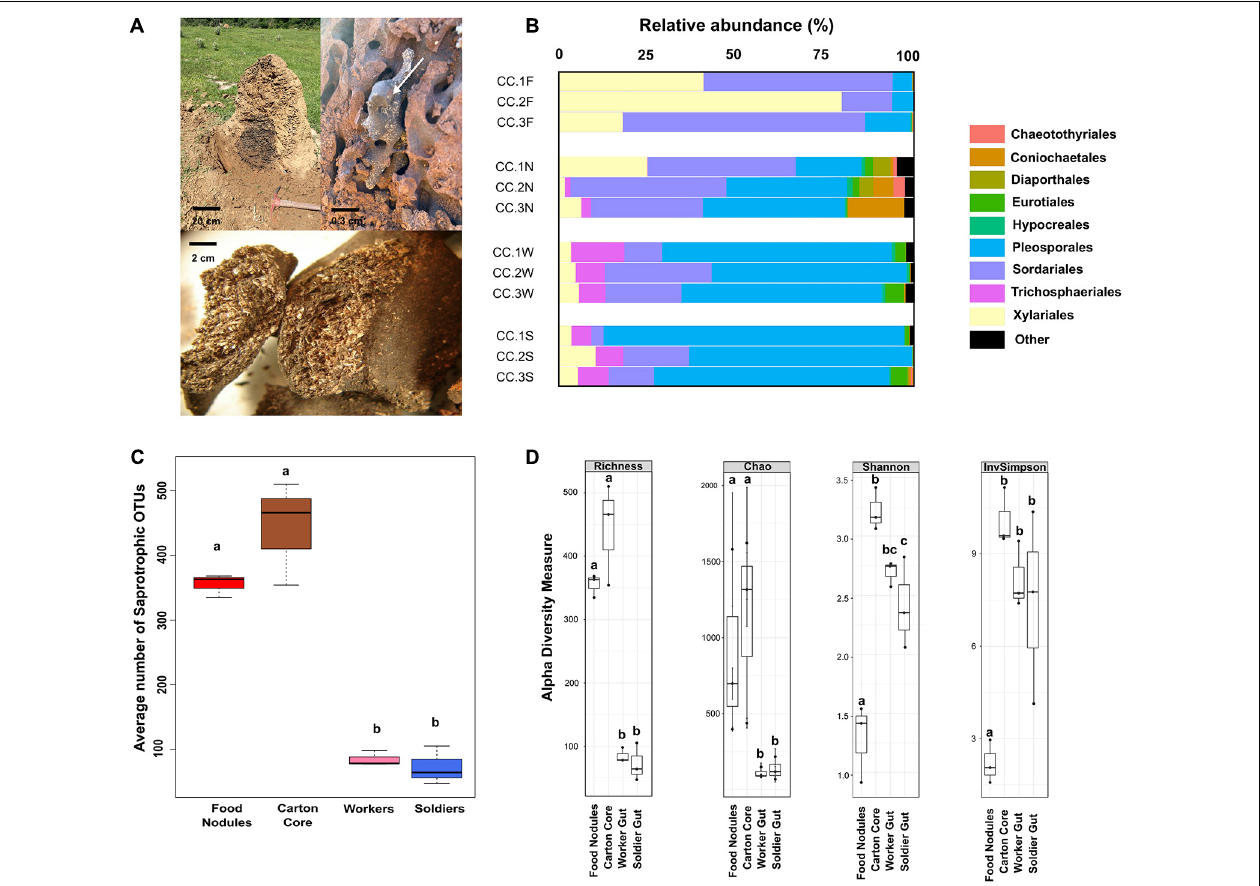
FIGURE 1 | (A) Nest of Cornitermes cumulans showing the central carton core with a food nodule (arrow) and a zoomed picture of the plant material inside a food nodule. (B) Proportion of reads assigned to different fungal orders in gut and nest substrates for each sampled colony. (C) Average number of saprotrophic fungal OTUs associated to each one of the samples. (D) Alpha-diversity indices estimated for fungal ITS amplicons. Graphics report the observed operational taxonomic units (OTUs) richness, Chao1 estimator of richness, and Shannon’s and Simpson’s indices. Boxplots report median, upper and lower quartiles, and maximum and minimum values. Different letters denote significant differences ( p -values < 0.05 in GLMM). Samples codes: CC1 = colony 1, CC2 = colony 2, and CC3 = colony 3. F, food nodules; N, carton nest core; W, worker gut; S, soldier